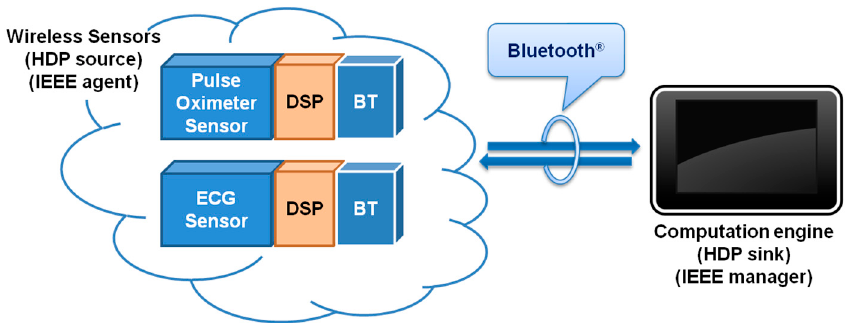
Figure 2. IEEE agent for physiological data acquisition, processing, and transmission ( left ); and IEEE manager smartphone application for patient empowerment ( right ).